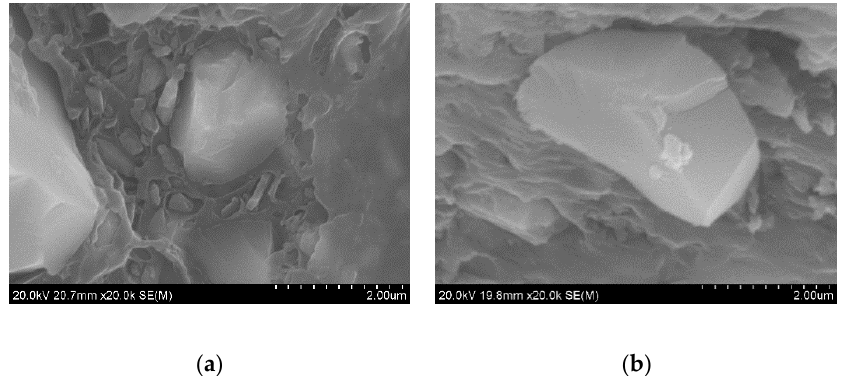
Figure 1. SEM photos of 30 vol.% composite filament ( a ) with surface modification; ( b ) without surface modification.